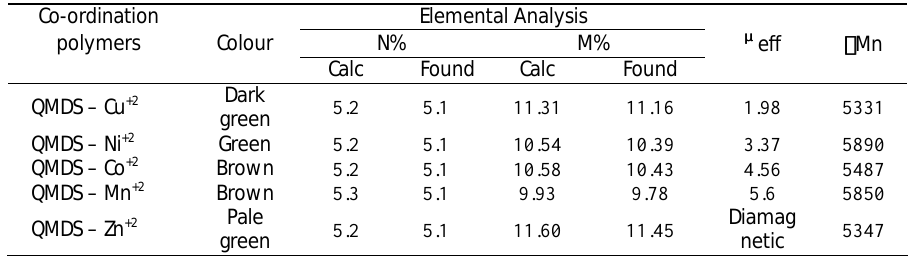
Table I. Table I. Analytical data for co-ordination polymer of